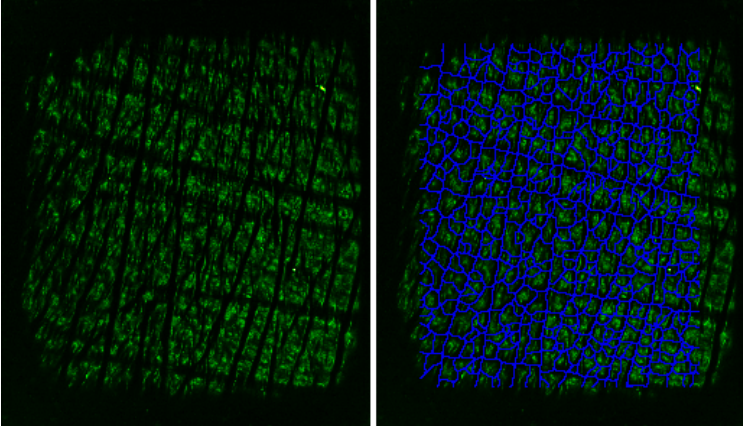
Figure 5. Example of gradient-based segmentation algorithm applied on capacitive image from the palm thenar. Right, the original and left the segmented frame. The lines that overlap with skin furrows represent the sizeless boundaries between segments. Reproduced with permission from [33], John Wiley and Sons,